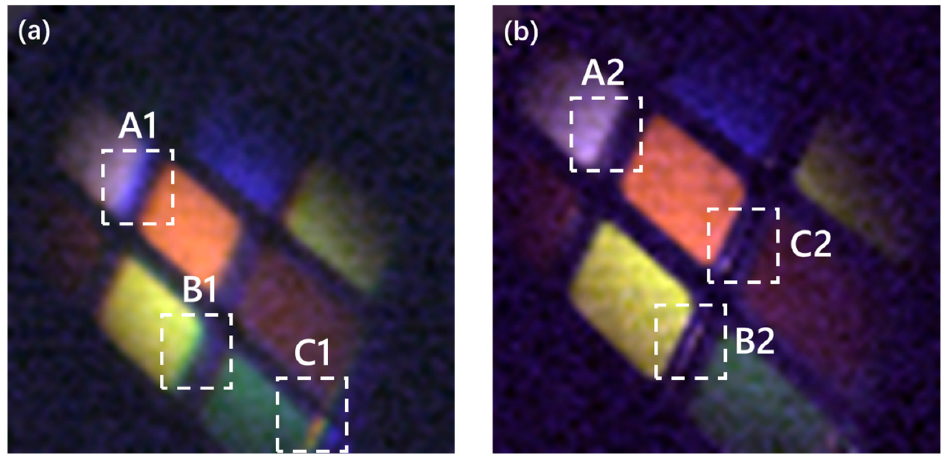
Figure 8. Reconstructed colored images of the control group ( a ) and the TV lens group ( b ). The white boxes show the main differences: purple or yellow haloes appear at the edges of the color blocks in ( a ), while in ( b ), even details such as the white edges in boxes B2 and C2 are clearly revealed.